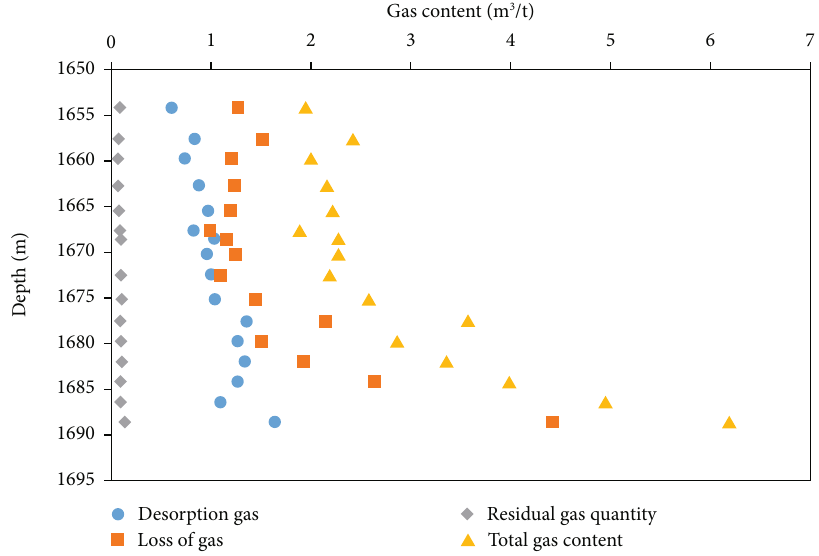
Figure 15: Curves showing vertical variation in the gas content of well